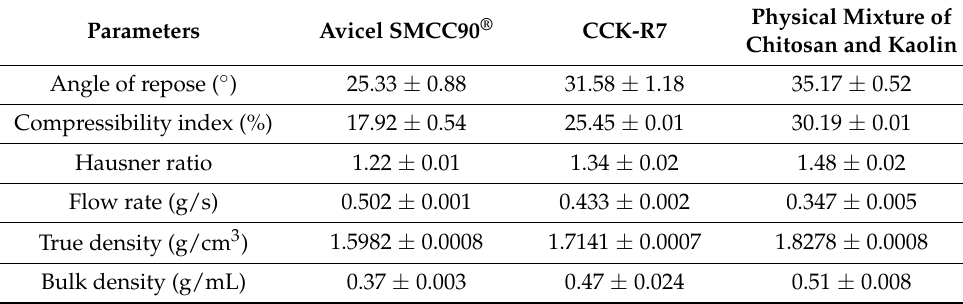
Table 5. Flow properties of three types of